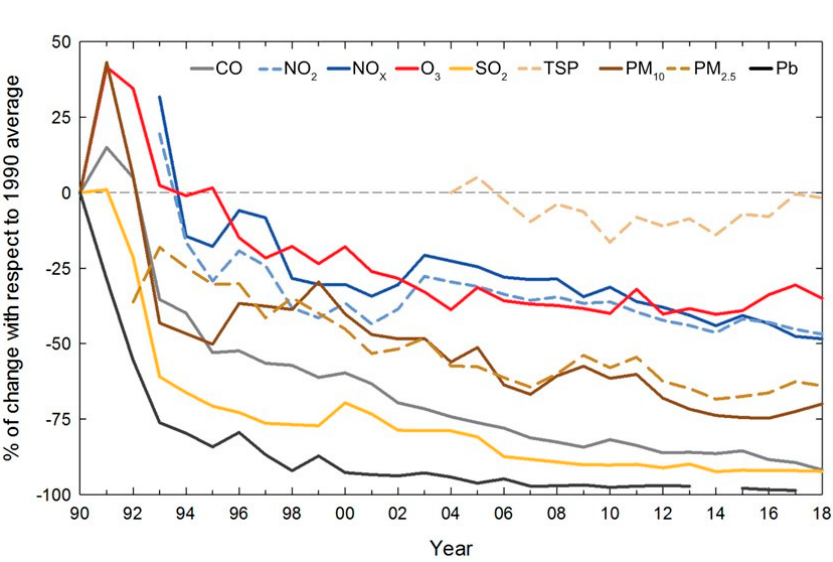
Figure 3. Percentage of change of the annual average concentration with respect to the annual average of 1990 for each of the main air pollutants in the MCMA. For PM 2.5 , the reference is the annual average of 2004. Averages were calculated for sites with ≥ 75% of valid data (graphs plotted by authors with information obtained from SIMAT website